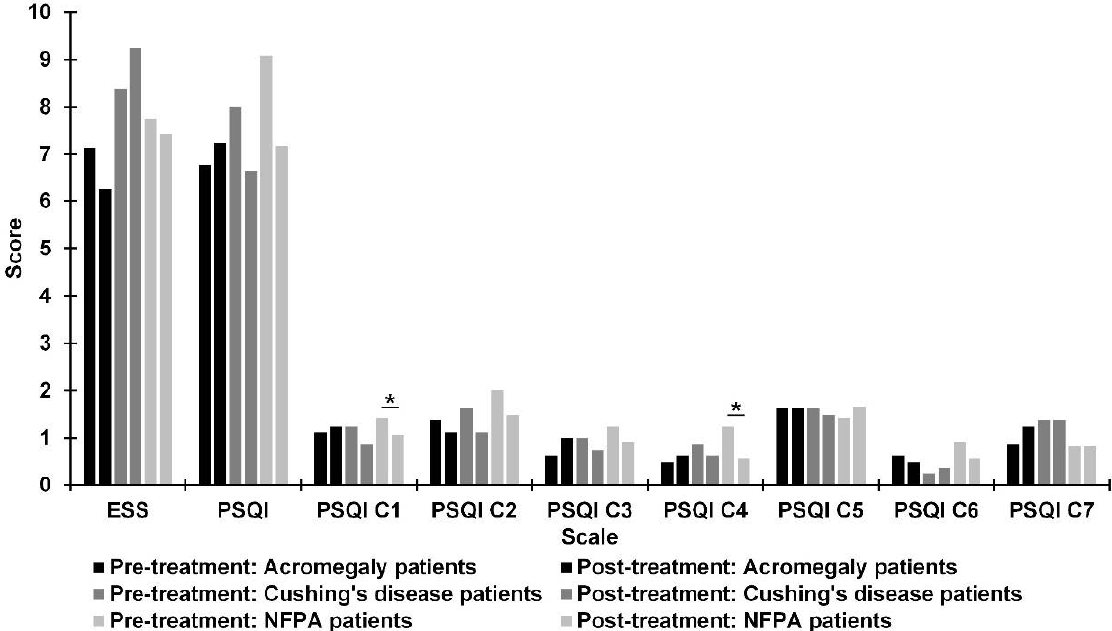
Figure 2. Differences between pre- and post-treatment in patients with acromegaly, patients with Cushing’s disease, and non-functioning pituitary adenoma (NFPA) patients on Epworth Sleepiness Scale (ESS) scores and Pittsburgh Sleep Quality Index (PSQI) scores. PSQI: C1 = Subjective Sleep Quality; C2 = Sleep Latency; C3 = Sleep Duration; C4 = Sleep Efficiency; C5 = Sleep Disturbances; C6 = Use of Sleeping Medication; C7 = Daytime Dysfunction. * p <